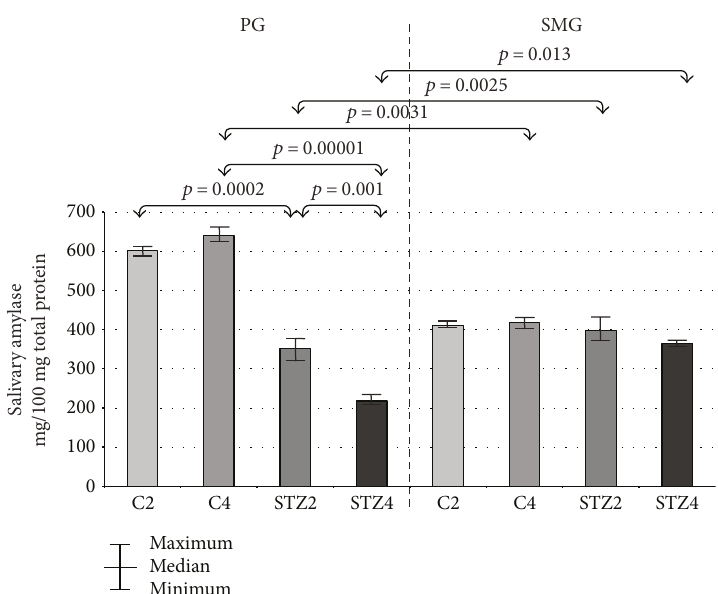
Figure 4: The e ff ect of STZ-induced diabetes on salivary amylase activity in the parotid and submandibular glands of rats. C2 and C4 are the control groups; PG: parotid glands; SMG: submandibular glands; STZ2 and STZ4 are the diabetic